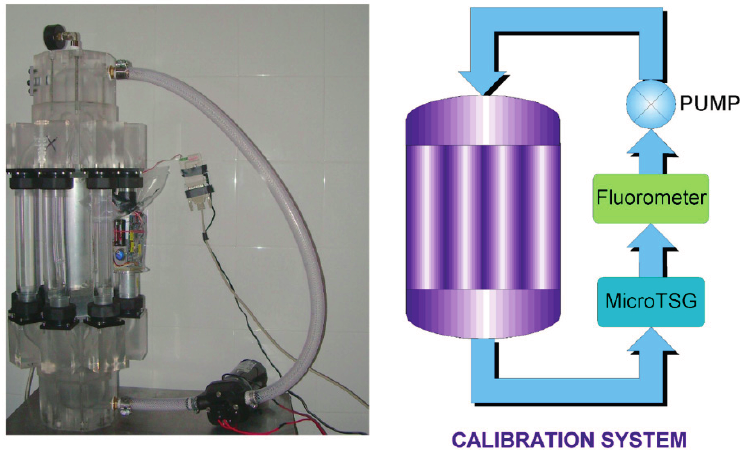
Figure 6. The calibration